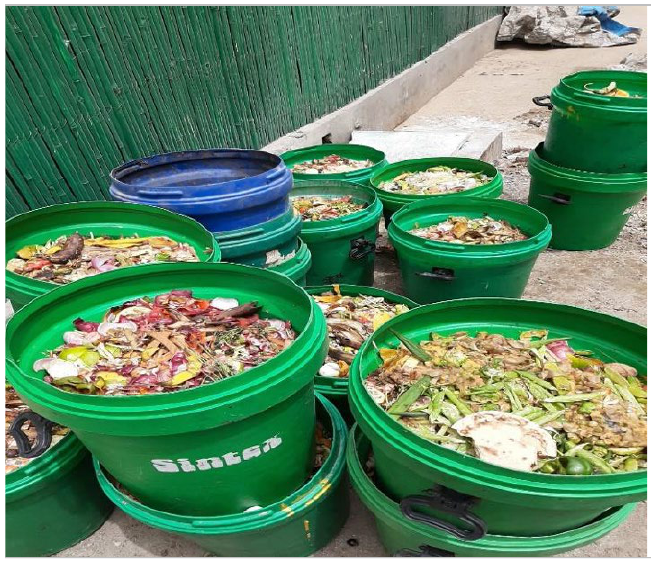
Fig. 3: Source segregation from house hold